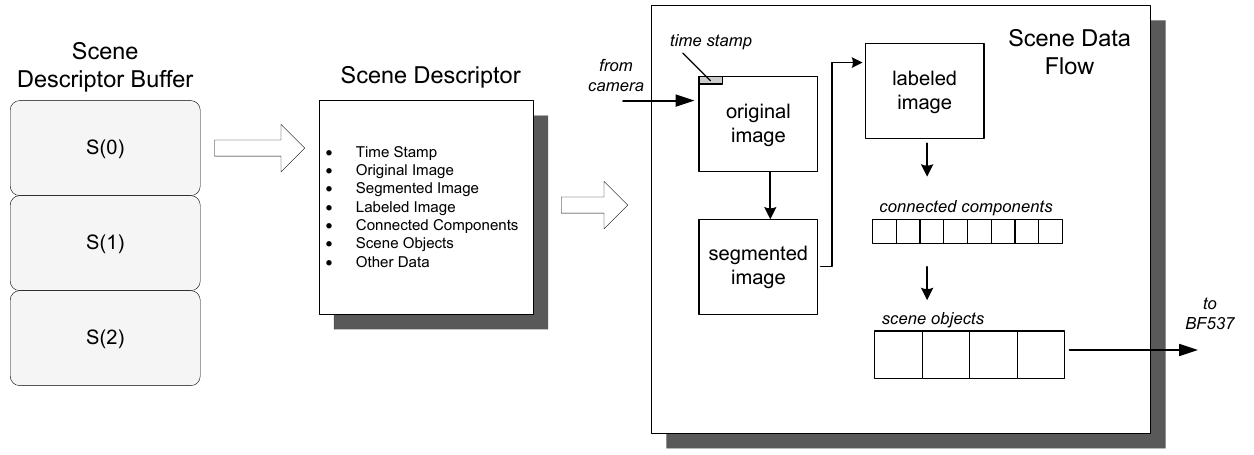
Figure 3. Scene Descriptor outline and information